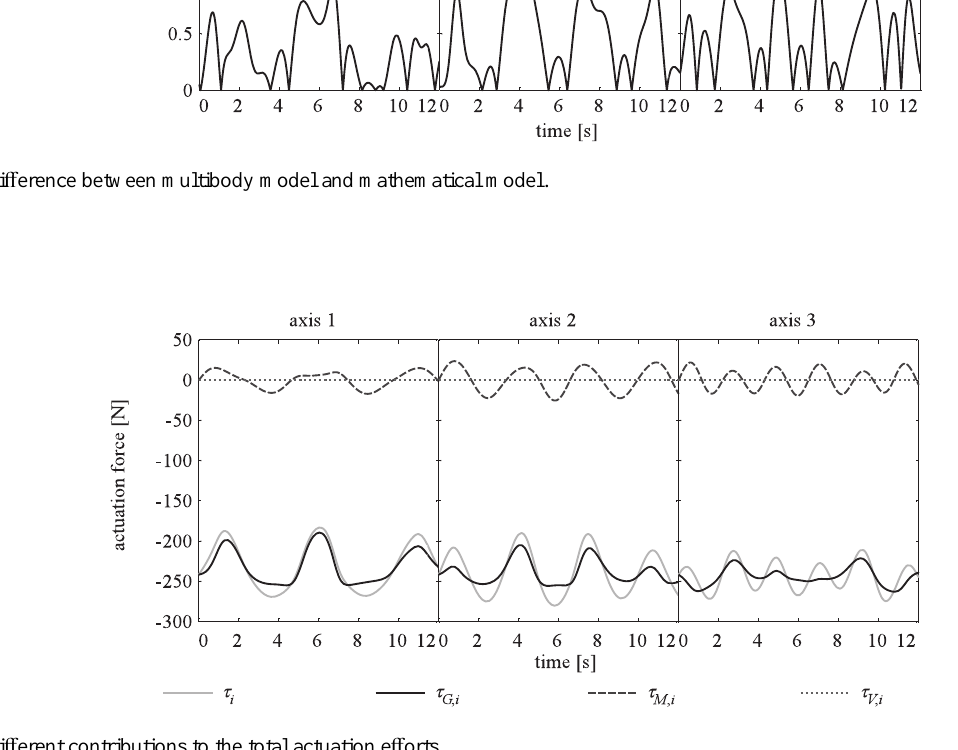
Figure 9. Di ff erent contributions to the total actuation e ff orts.